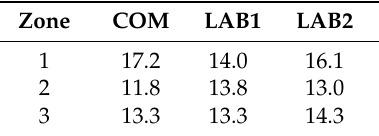
Table 4. Mean values of concentrations of O 2 during combustion tests.